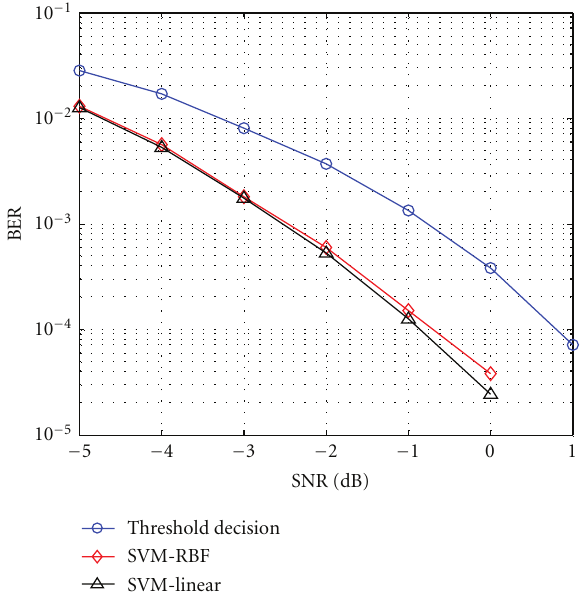
Figure 2: Demodulation with SVM-RBF, SVM-linear, and thresh- old decision.